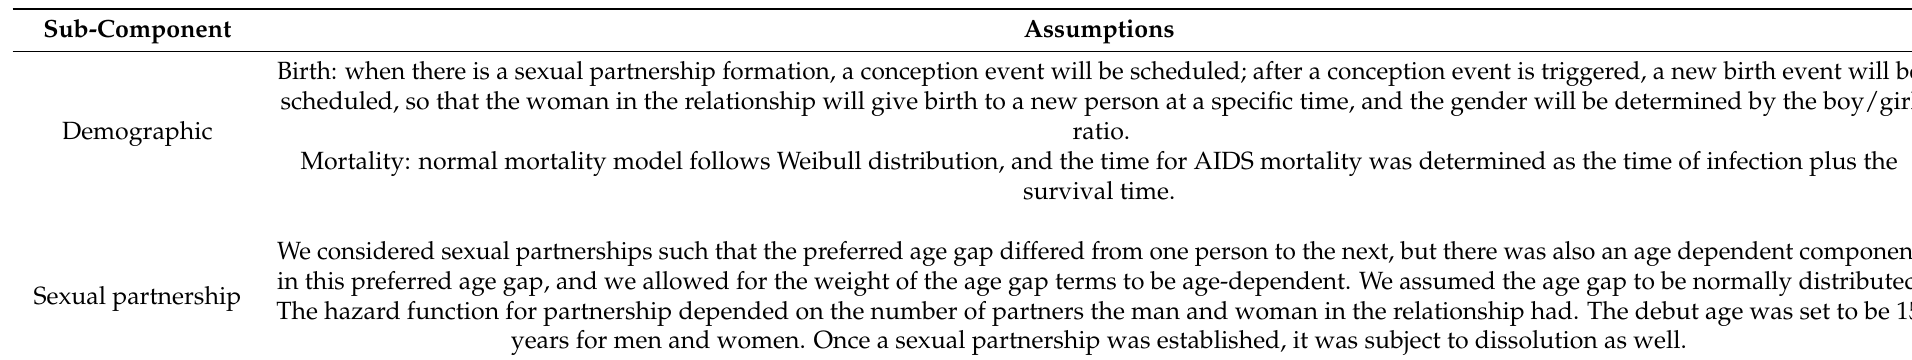
Table A2. Main assumptions for the simulation of the dynamic sexual partnership network and HIV